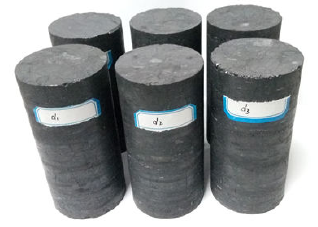
Figure 2. Standard raw coal